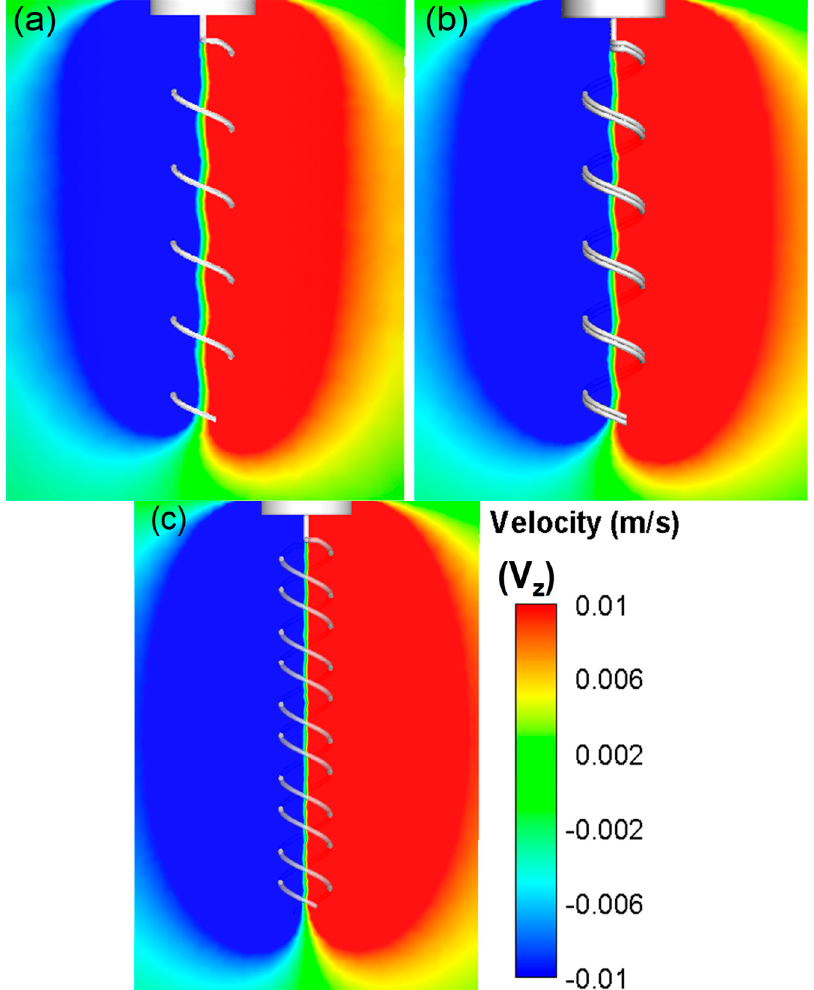
Figure 7. CFD simulations for tangential velocity V z distribution along the center axis of the three major flagella configurations. It shows both inclusion of additional flagellum and phase angle between the flagella increase the flow momentum that is convected in the radial direction. Radial momentum decayed approximately 3, 3 1/2 and 4 helix diameters away from the single flagellum ( a ), in-phase ( b ) and out-of-phase ( c ) double flagella configurations, respectively.